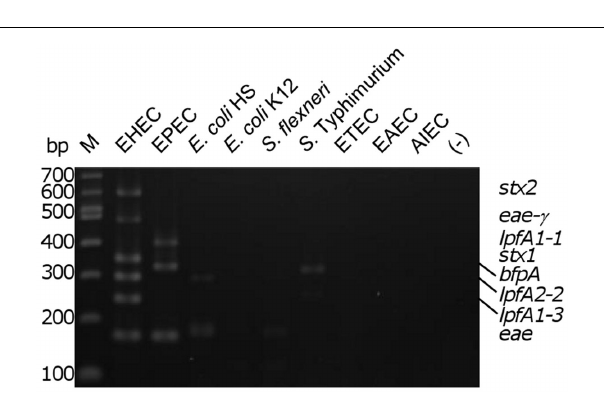
FIGURE 2 | Determination of biological assay specificity. Multiplex PCR assay was performed using gDNA from pathogenic and commensal enteric bacteria. M, 100bp DNA markers (NEB); EHEC, enterohemorrhagic E. coli ; EPEC, enteropathogenic E. coli ; E. coli HS and E. coli K12, human intestinal commensal and laboratory strains; S. flexneri , Shigella flexneri ; S. typhimurium , Salmonella enterica serovarTyphimurium 2157; ETEC, enterotoxigenic E. coli H10407; EAEC, enteroaggregative E. coli O42; AIEC, adherent/invasive E. coli O83:H1; ( − ), no template control.The position of the amplicons in the EHEC and EPEC strains are indicated on the right of the